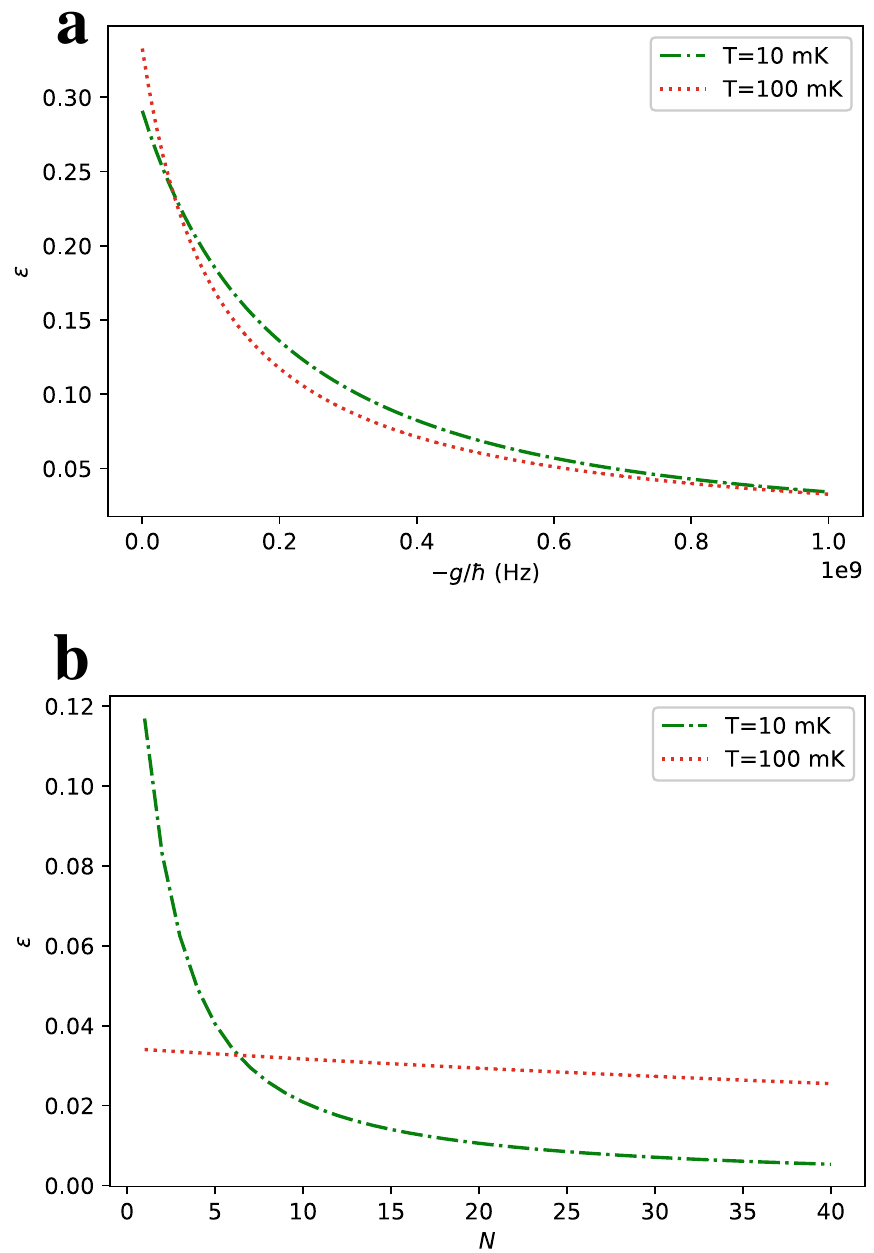
Figure 3. Efficiency ε of the refrigeration cycle defined in Eq. (9) as a function of ( a ) interaction strength g with N = 6 and ( b ) number of ancilla qubits N with g = − h at different environment temperatures T and for h = 1